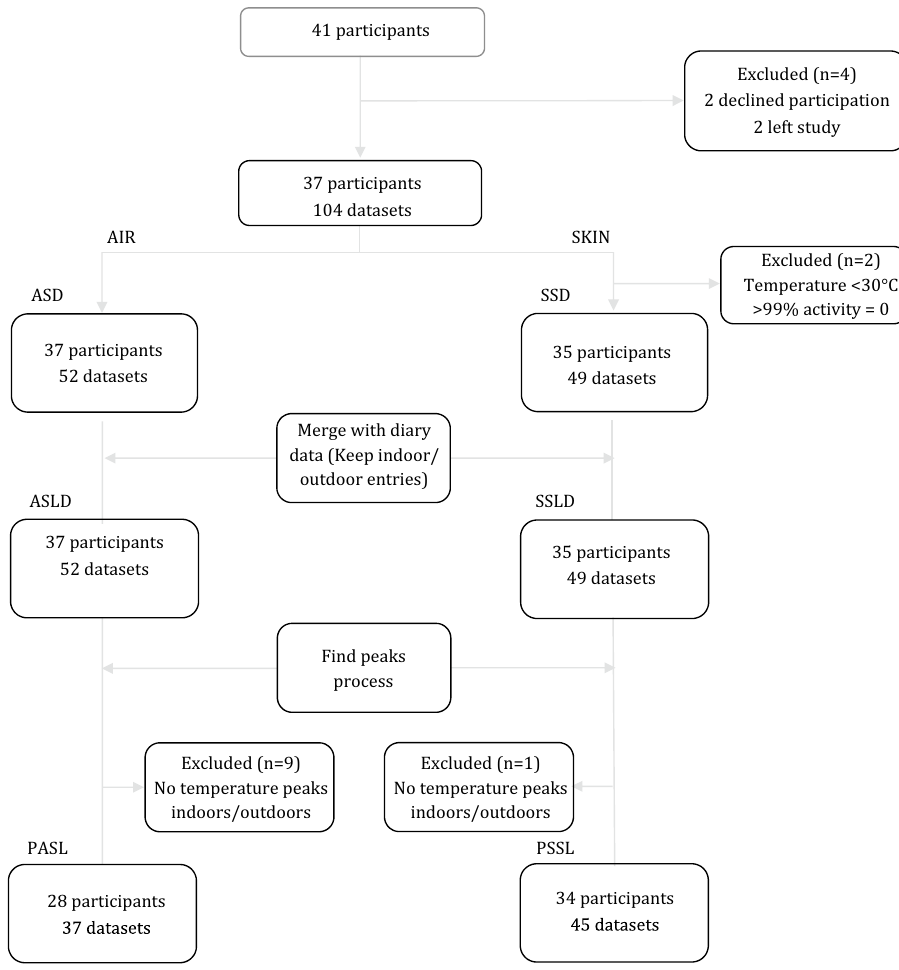
Figure 1. Flow chart of participants and datasets included in the analysis per sensor